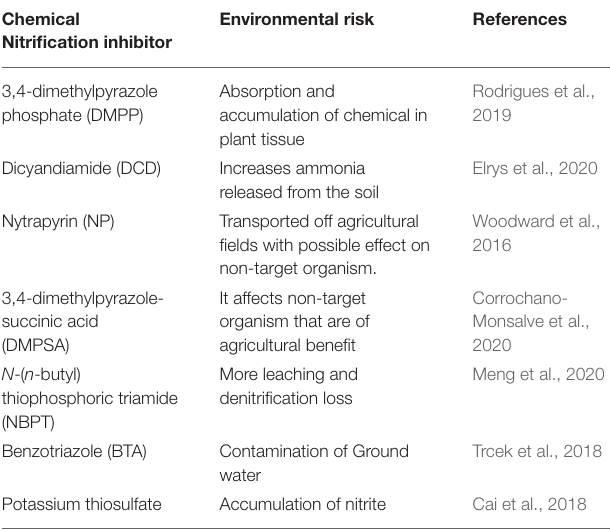
TABLE 2 | Environmental risk of chemical nitrification